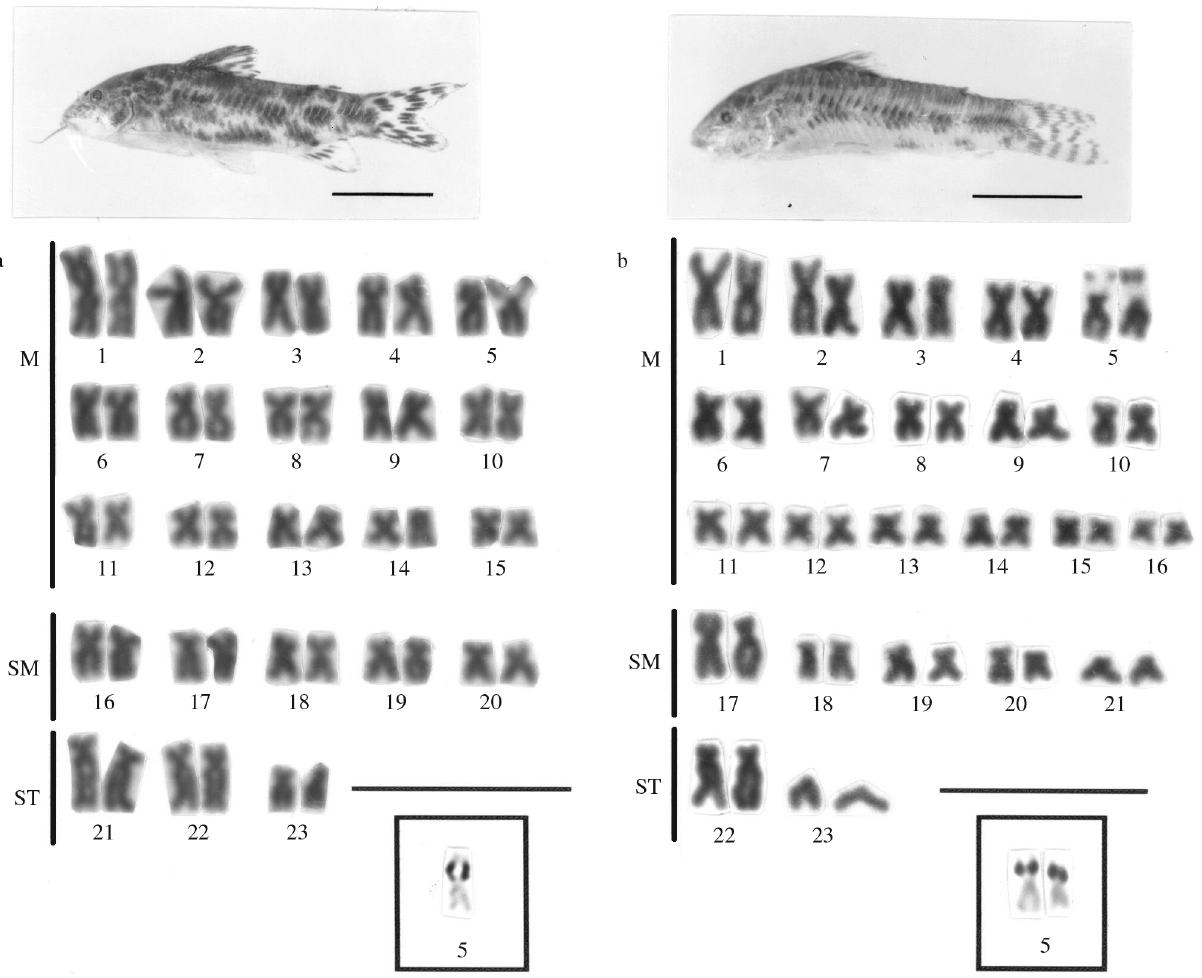
Figure 1 - Karyotypes, Ag-NORs and specimens of: a) Aspidoras taurus , 2n = 46 and b) A. cf . fuscoguttatus , 2n =